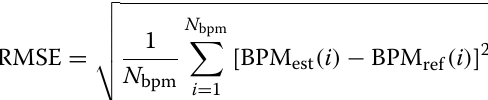
where N bpm denotes the calculated HR number in the observation, BPM est ( i ) denotes the i -th estimated HR from Doppler radar, and BPM ref ( i ) denotes the i -th estimated HR from ECG, in units of beats per minute (BPM).